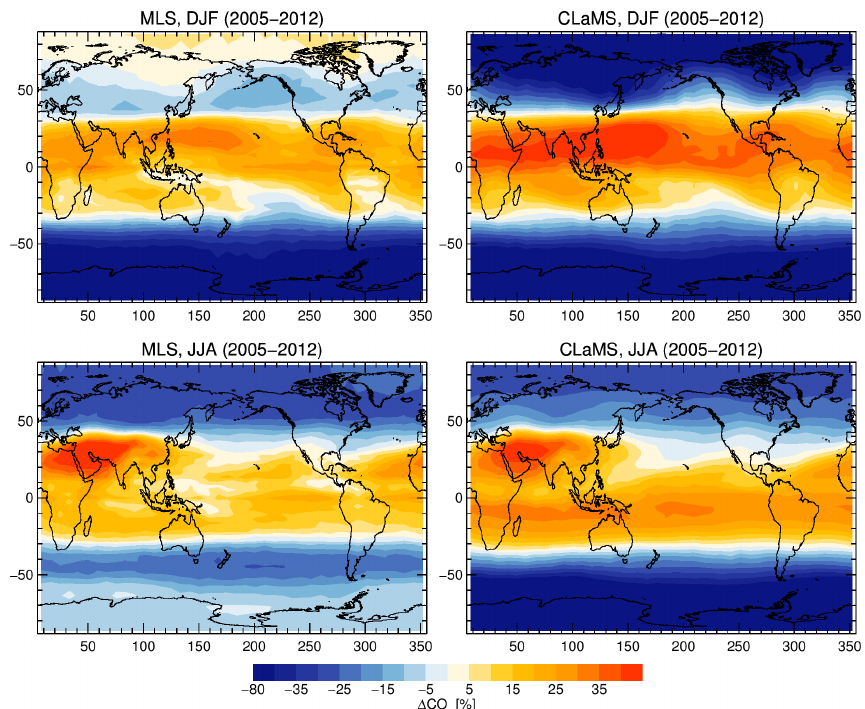
Figure 2. Comparison of the climatological anomalies of the CLaMS simulations with MLS measurements at the 390K potential temperature surface. CLaMS CO values were interpolated on the locations of the MLS measurements and vertically smoothed with the MLS averaging kernels. For both measured (left hand panels) and simulated (right hand panels) CO values the climatological anomaly (with respect to the mean value at the 390K potential temperature level) for the time period 1 January 2005 to 31 October 2012 is shown (see text for details). Top panels show northern hemisphere winter (DJF) conditions, bottom panels show northern hemisphere summer (JJA) conditions. (Note that the largest bin for negative anomalies ranges from − 80 to − 40% because the negative anomalies reach rather large